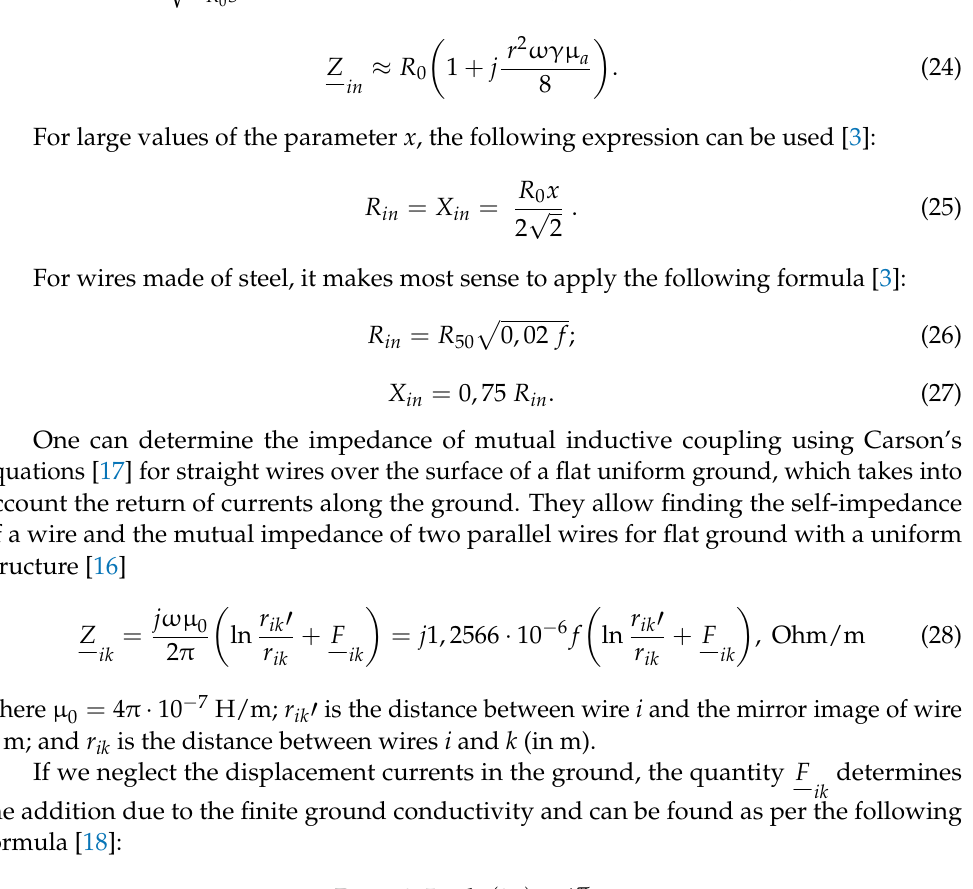
Figure 5. Original circuit of the power transmission line.